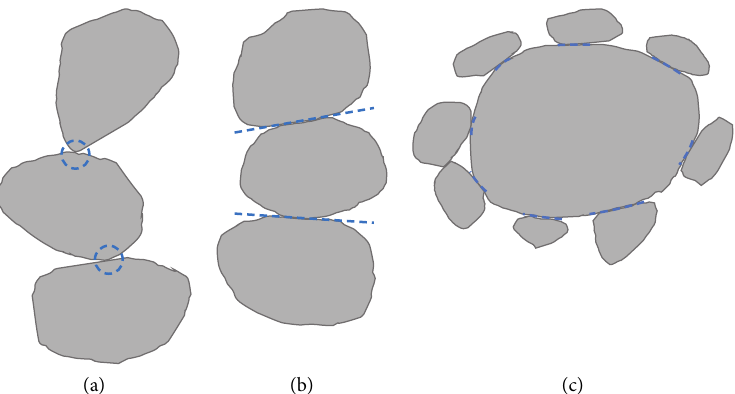
Figure 10: Typical contact patterns of calcareous sand particles. (a) Point-like contact. (b) Extended contact. (c) Contact L-S.